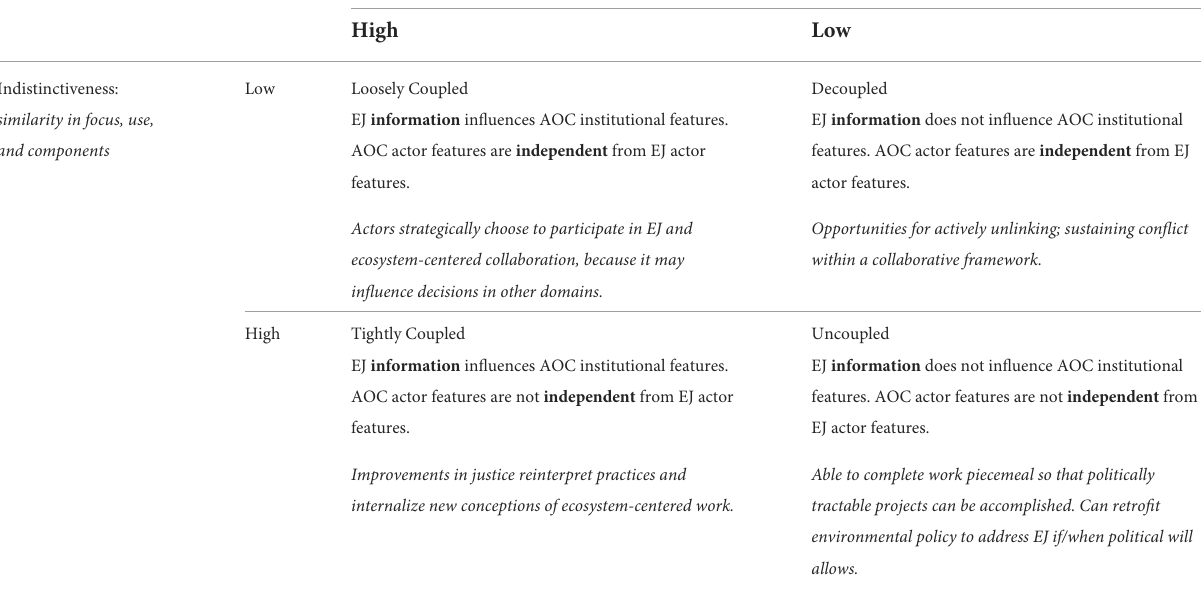
TABLE 1 Coupling definitions and implications for hybrid governance linking ecosystem-centered work with environmental justice